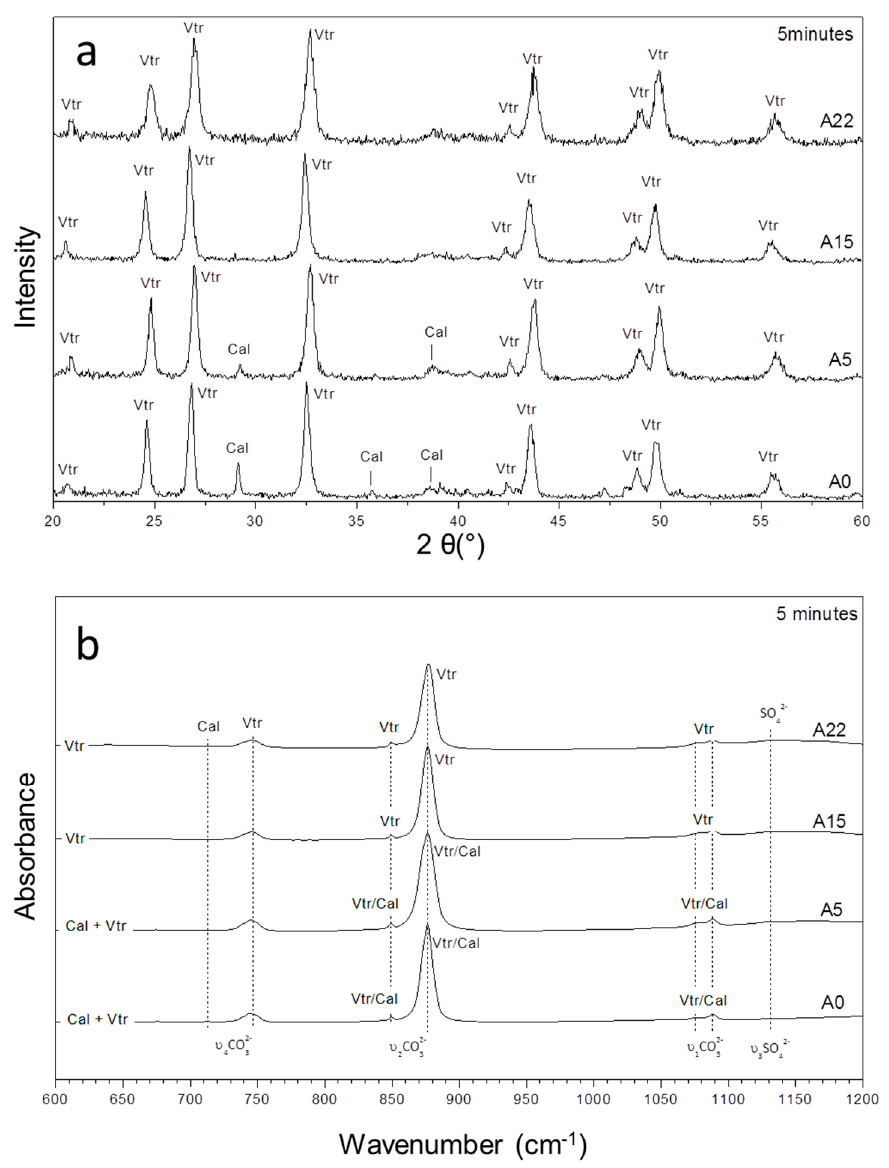
Figure 1. The XRD patterns ( a ) and infrared spectra ( b ) of precipitates sampled after 5 min of reaction in the case of experiments A0, A5, A15, and A22 with initial (SO 42 − )/(CO 32 − ) ratios of 0, 14.0, 41.8, and 60.0, respectively.